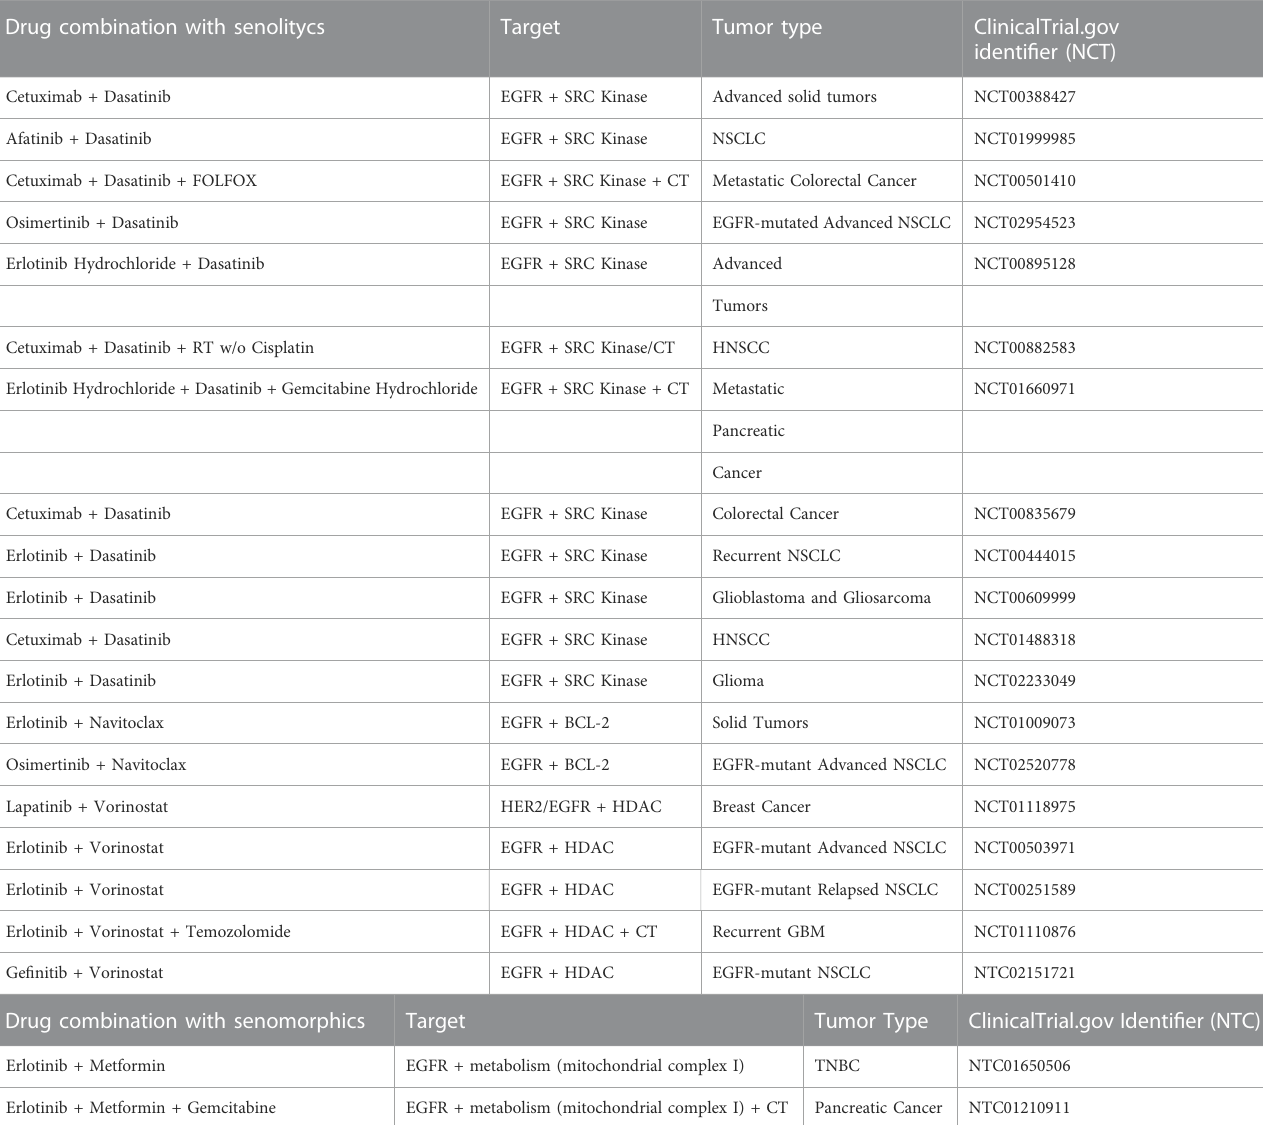
TABLE 1 Listed are all clinical trials with senolytics and senomorphics combined with anti-EGFR therapies applied to different tumor types. Radiotherapy (RT); Chemotherapy (CT); Non-Small Cell Lung Cancer (NSCLC); Head and Neck Squamous Cell Carcinoma (HNSCC); Glioblastoma Multiforme (GBM); Triple Negative Breast Cancer